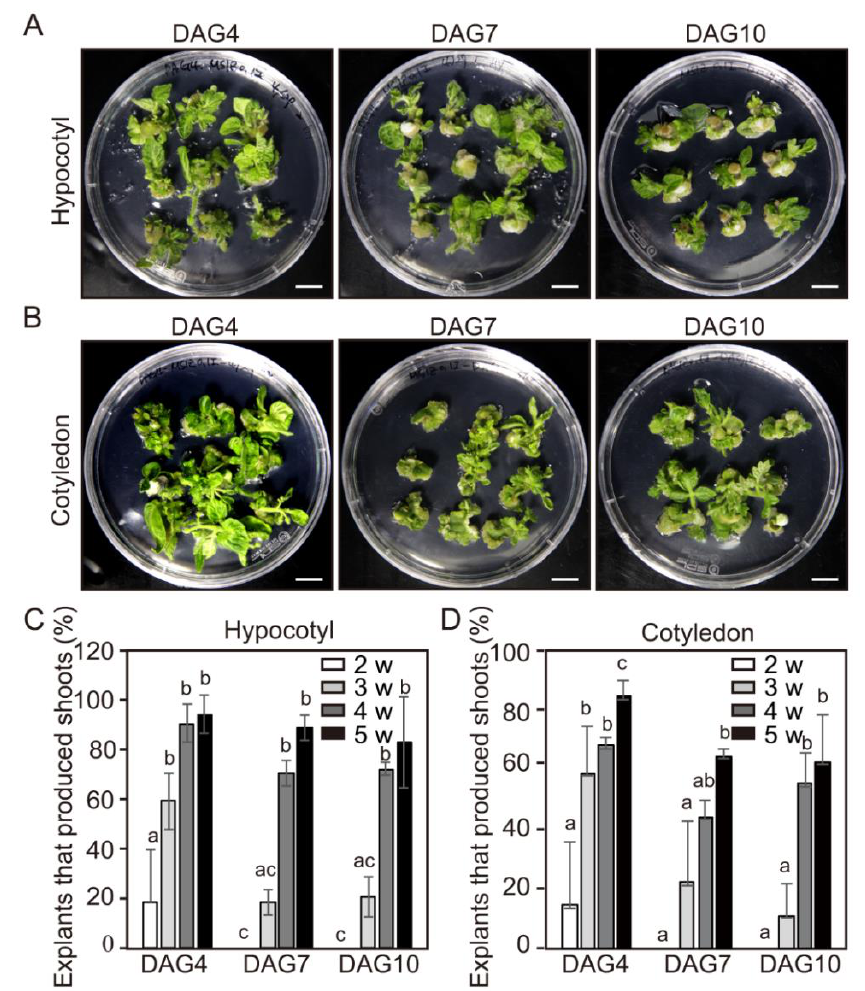
Figure 2. The efficiency of adventitious shoot formation from hypocotyl and cotyledon explants of tomato from seedlings of different ages. ( A , B ) Adventitious shoot formation from hypocotyl ( A ) and cotyledon ( B ) explants of DAG4, DAG7, and DAG10 seedlings cultured in the shoot induction medium (SIM) for 4 weeks. Explants of cotyledons for all treatments were placed an abaxial orientation. Scale bars = 1 cm. ( C , D ) The efficiency of adventitious shoot formation from hypocotyl ( C ) and cotyledon explants ( D ) of DAG4, DAG7, and DAG10 seedlings examined after 5 weeks of culture in SIM. Data are representative of three independent experiments and values are expressed in mean ± SD (N = 81). Different letters on the bars indicate significant differences between each treatment (ANOVA followed by a Turkey’s test, p < 0.05). DAG = day after germination; w = weeks.